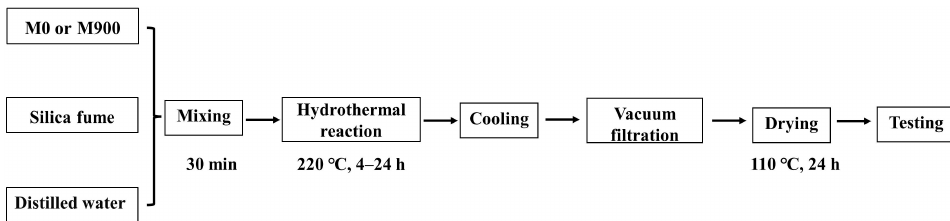
Figure 2. Flowchart of hydrothermal synthesis of xonotlite.